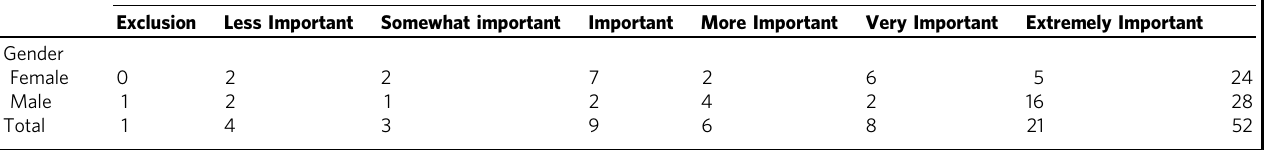
Table 17 Valuations given to the abbreviated narrative of the History of Portugal ‘ Revolution of 25 April 1974 – Democratic Revolution, end of dictatorship ” and gender of